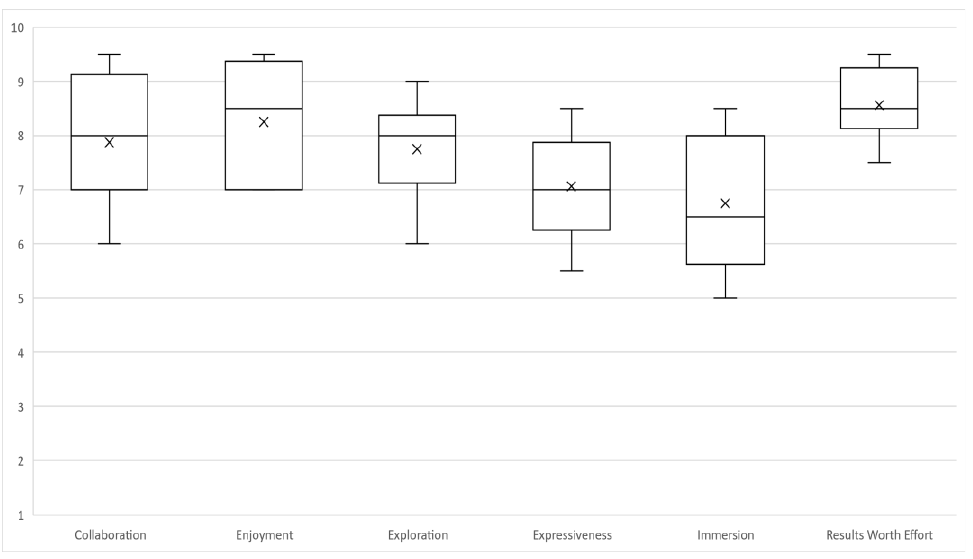
Figure 6. Participants ’ evaluation of Experienced Creativity.